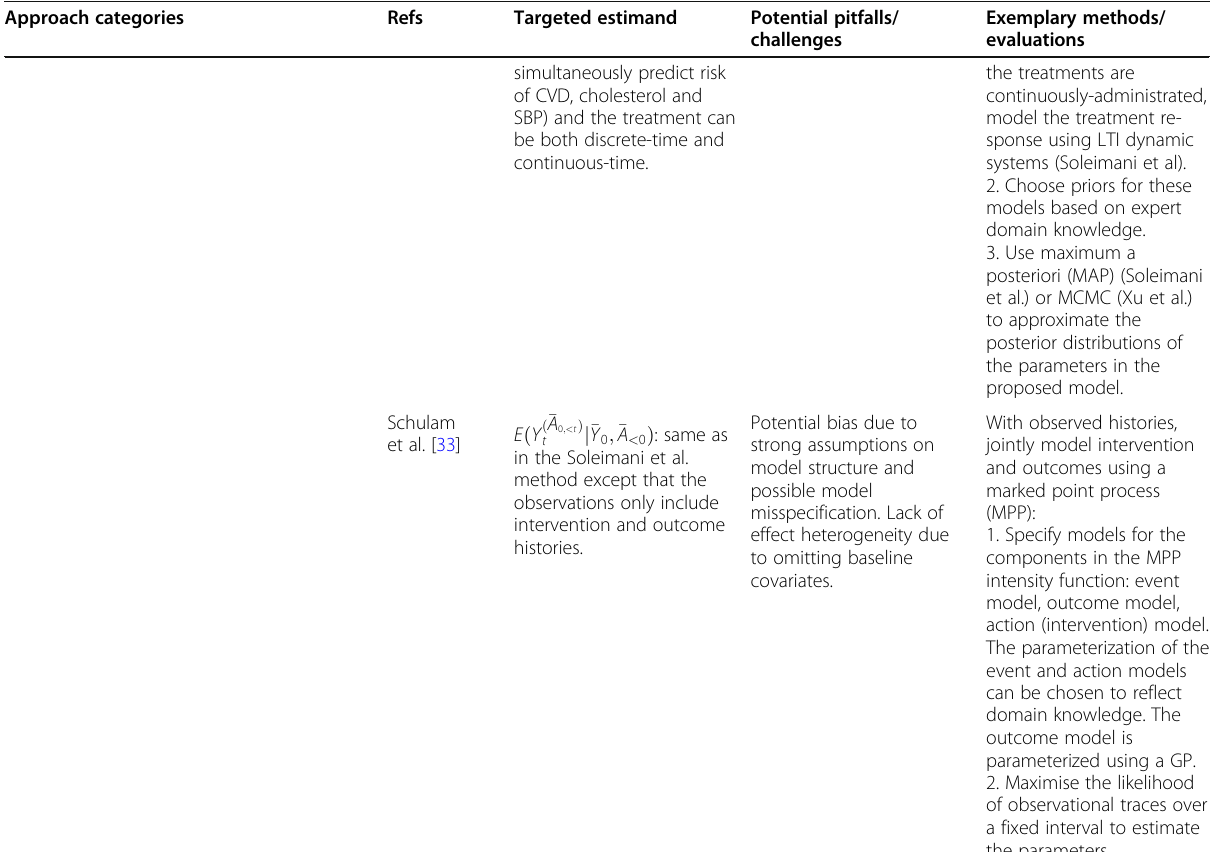
Table 2 Illustration of methods in different categories using an example of statin intervention in primary prevention of CVD (Continued) Approach